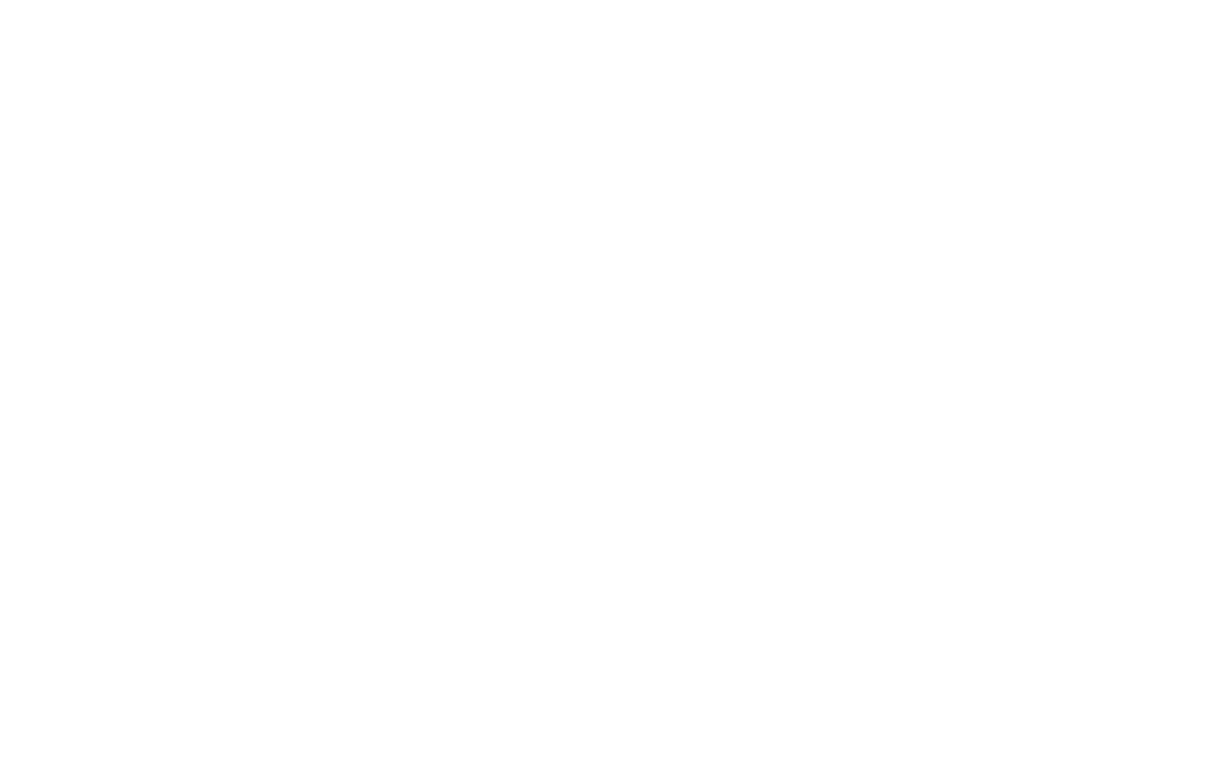
FIGUREA2 | Illustration of brain areas showing increasing amplitude of the hemodynamic response to target stimuli with longer target interval. Target interval effects were found in numerous brain structures, including bilateral thalamus, bilateral anterior insula, dorsal anterior cingulate, supplementary motor area, dorsolateral prefrontal cortex, bilateral middle temporal gyri, bilateral pre- and postcentral gyri